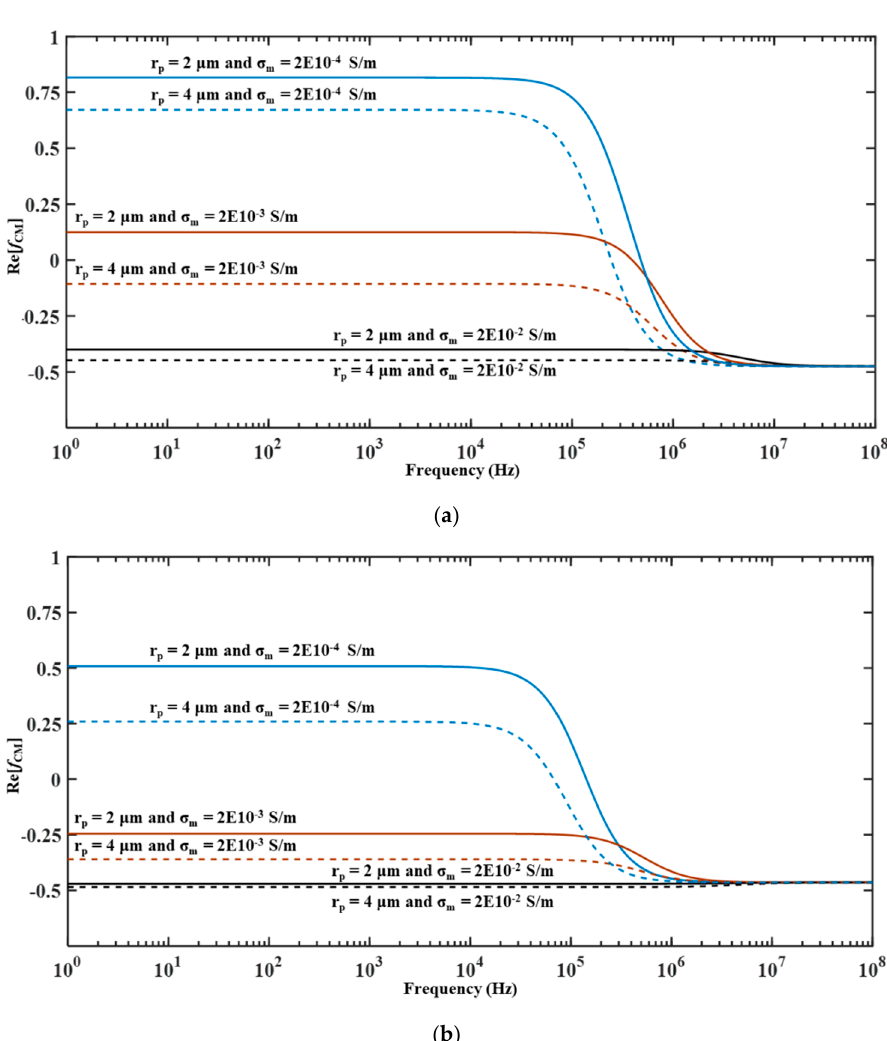
Figure 1. Variation of Re [ f CM ] with frequency for ( a ) polystyrene and ( b ) silica microparticles.